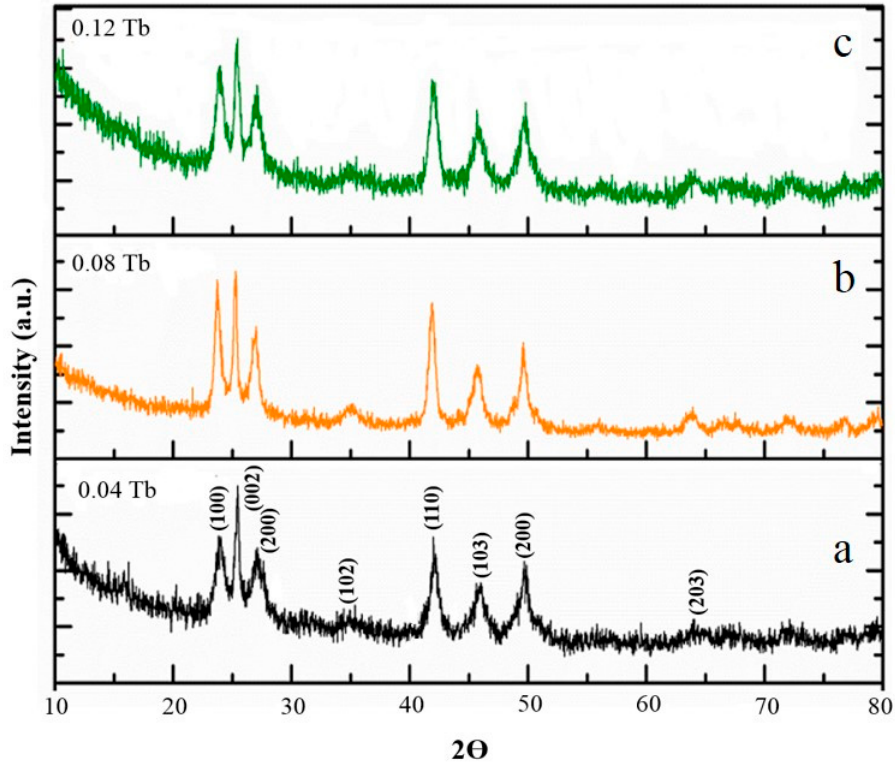
Figure 1. The powder X-ray diffraction pattern of Tb x Cd 1 − x Se (( a ) x = 0.04, ( b ) x = 0.08, ( c ) x = 0.12). SEM analyses were done to clarify the size and shape of the nanoparticles. Figures 2 and 3 show the SEM microphotographs of the CdSe and Tb-doped CdSe samples, respectively. Compared to the pure CdSe, the SEM images show a larger particle size of the terbium- doped CdSe nanoparticles. This proves that the doping of Tb 3+ ions into the CdSe lat- tice increases the aggregation of nanoparticles and correspondingly increases the size of the